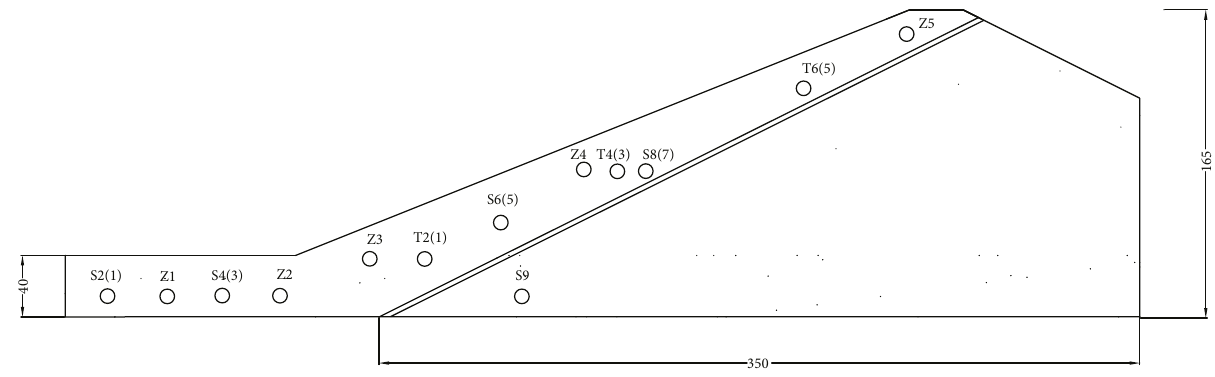
Figure 5: Front view of sensor embedding (unit: cm). S: osmometer, Z: matric suction sensor, and T: soil pressure